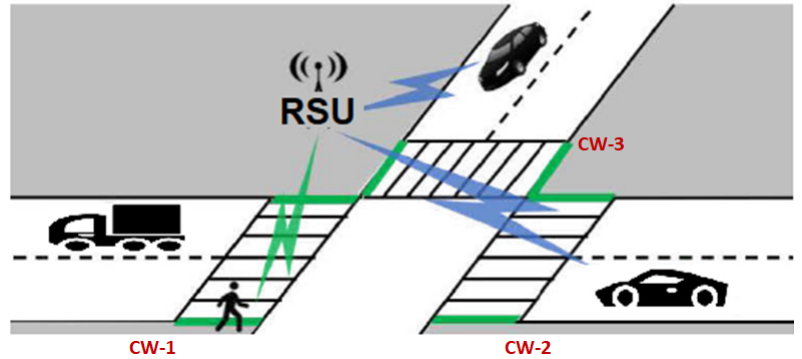
Figure 5. Crosswalk